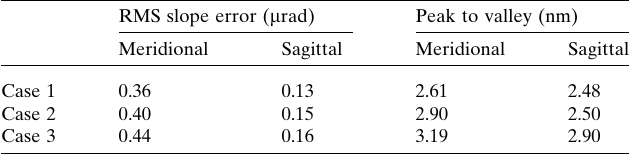
Table 2 Peak-to-valley of the figure error and RMS slope errors across the centre line of the optical surface of the crystal.